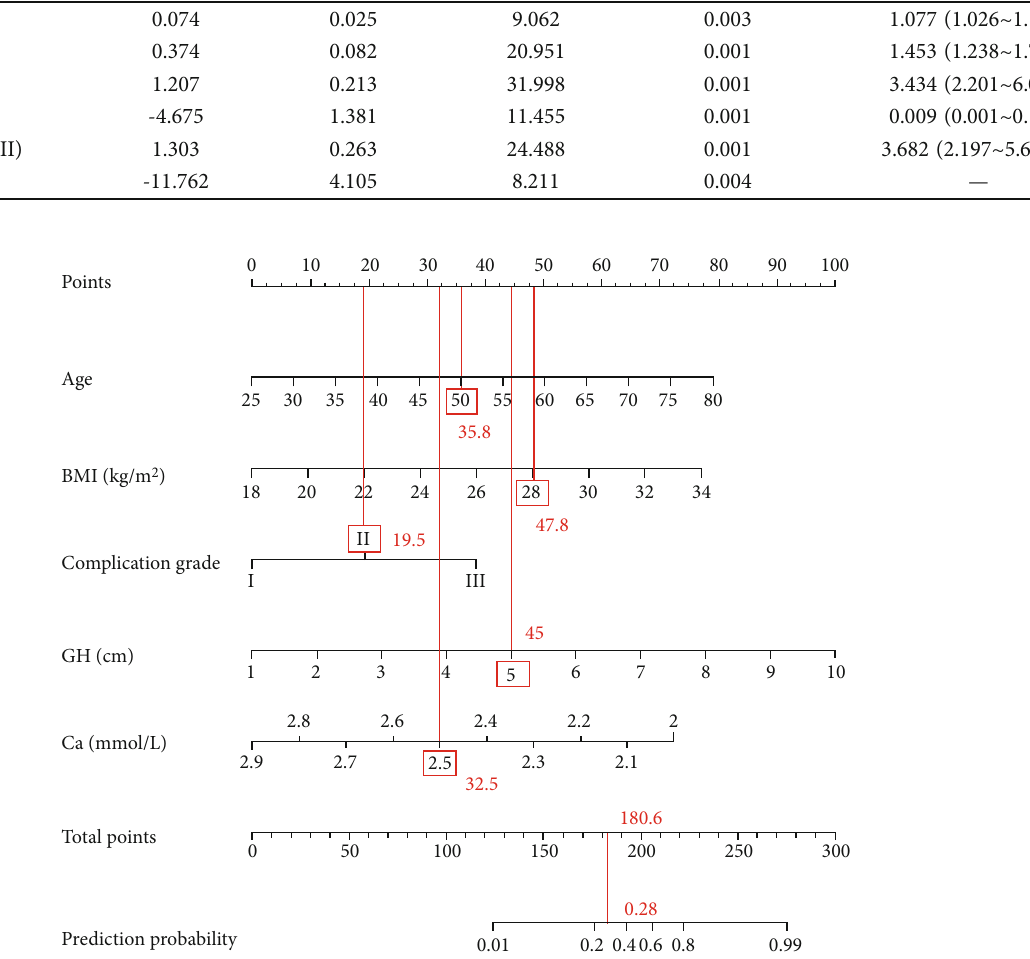
Figure 2: Nomogram model for predicting recurrence after